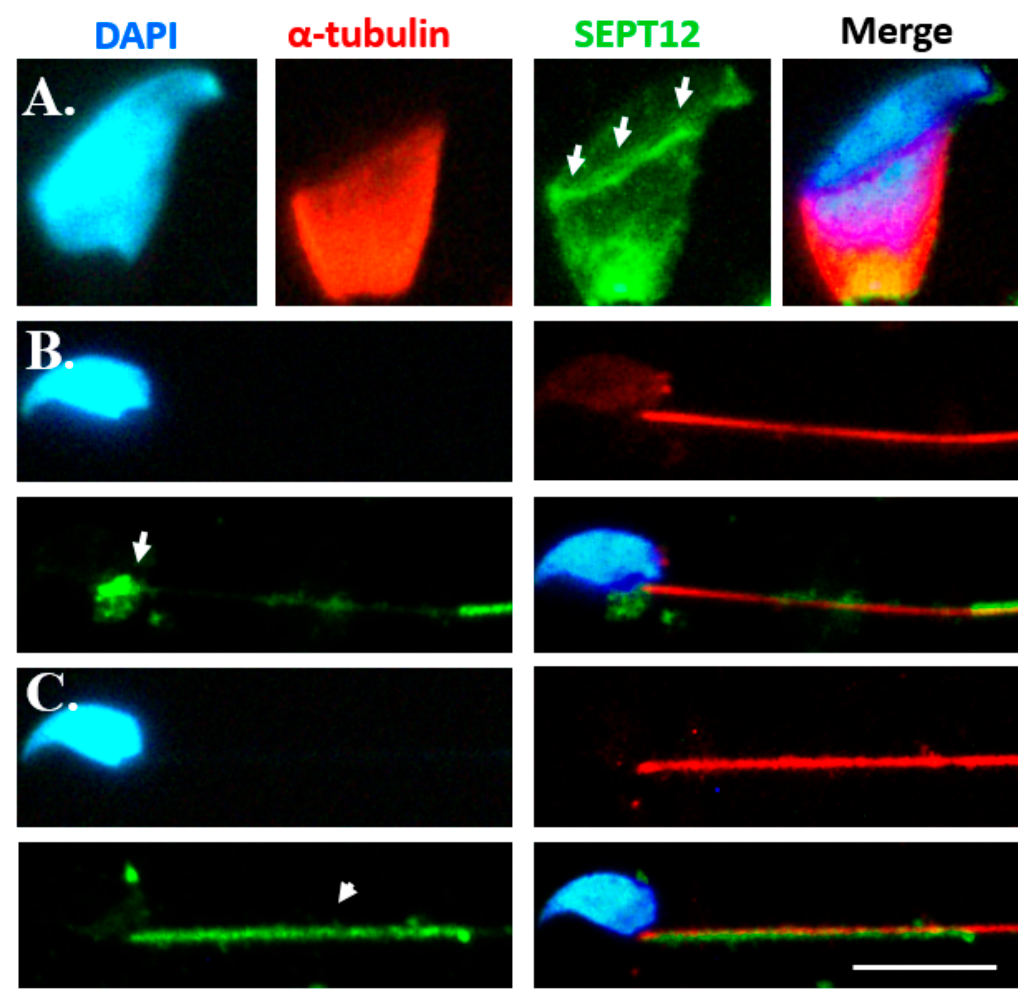
Figure 3. SEPT12 localization during murine spermiogenesis. IF staining results revealed multiple localizations of SEPT12 signals: ( A ) elongating spermatids, ( B ) elongated spermatids, and ( C ) mature spermatozoa. DAPI (“DAPI” panels), anti- α -tubulin antibody (“ α -tubulin” panels), anti-SEPT12 antibody (“SEPT12” panels), and a combination of DAPI, anti- α -tubulin antibody, and anti-SEPT12 antibody (“Merge” panels) were used as stains. Arrowheads indicate SEPT12 expression. Scale bar = 10 μ m.